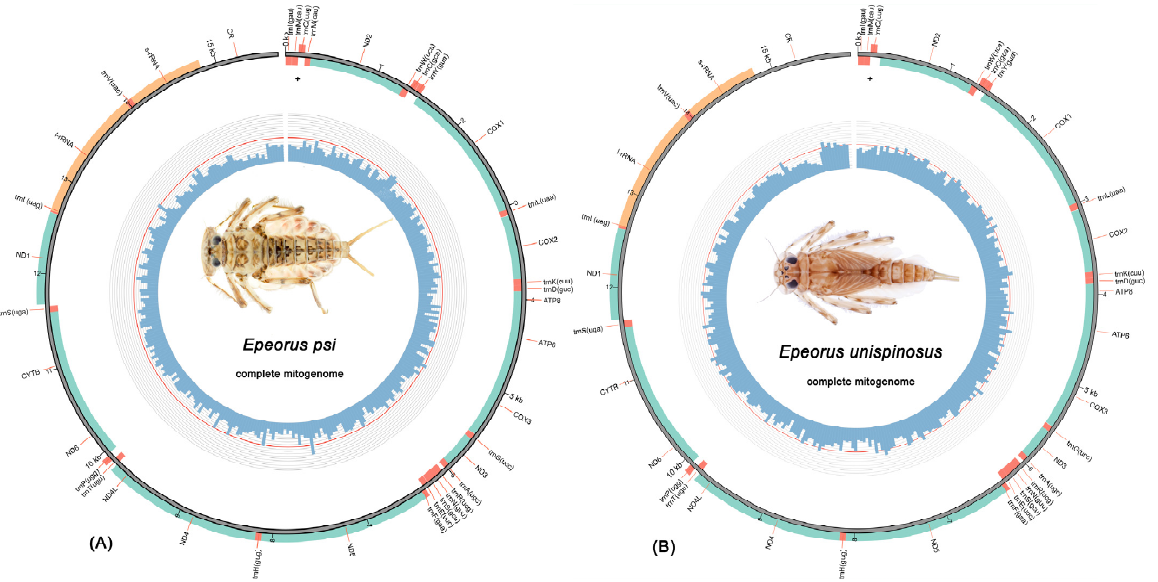
Figure 1. Mitochondrial maps for two types of rearrangement in Epeorus : ( A ) E. psi (with gene block trnI-trnM-trnQ-trnM-ND2 ); ( B ) E. unispinosus (with gene block trnI-trnM-trnQ -NCR- ND2 ).